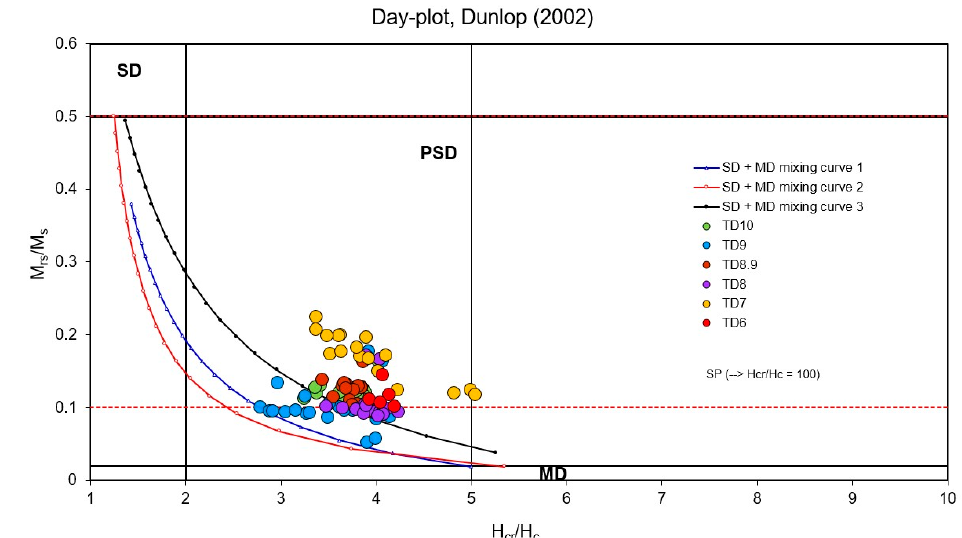
Figure 10. Day-plot diagram showing the ratios distribution of each stratigraphic unit [49]. To further characterize the grain size variation of the particles, we use the so-called King plot [51] that compares the anhysteretic susceptibility (calculated dividing the ARM for the bias field) and the low-field susceptibility; the slope of the alignment defines the grain size of particles. We distinguish three different grain size groups. The smallest grain size family (light blue in Figure 11) corresponds to the samples from the middle-upper part of TD9, coherently with the interpretation of the IRM 1T / χ lf profile (Figure 8c). A second group is due to the specimens from unit TD7 (yellow in Figure 11), representing the largest magnetic grain size. Finally, most specimens of the other units show an intermediate size between these two extremes.